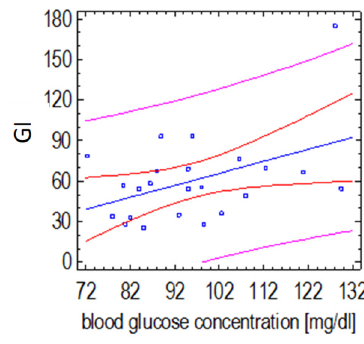
Figure 7. Relationship between the GI value of strawberry sorbet with plant-based formula supplement and postprandial glucose concentration 60 min after its consumption (Spearman’s correlation test). (the red lines define prediction limits; the pink lines define confidence limits (95%); the blue dots are the results obtained).